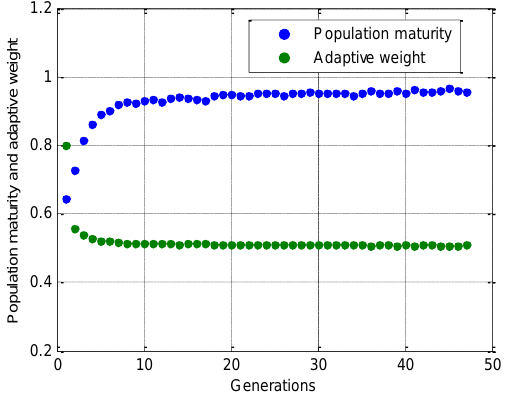
Figure 2. Trend of Population maturity and adaptive weight